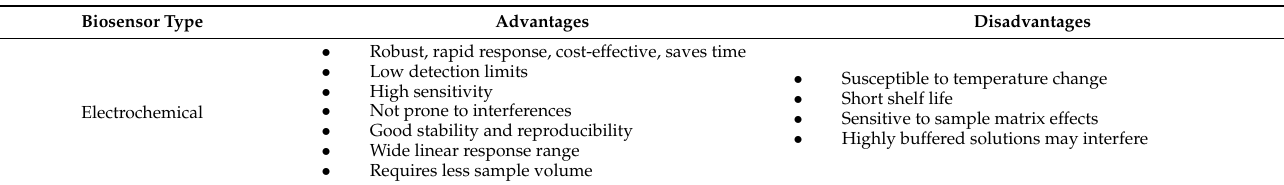
Table 1. Advantages and disadvantages of transducer-based